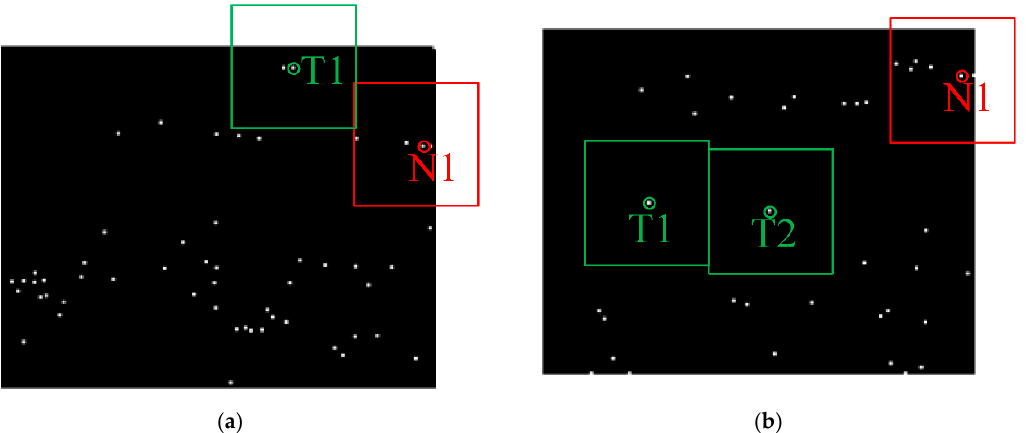
Figure 9. Local maximum detection results. ( a ) Local maximum result of image A. ( b ) Local maximum result of image B.